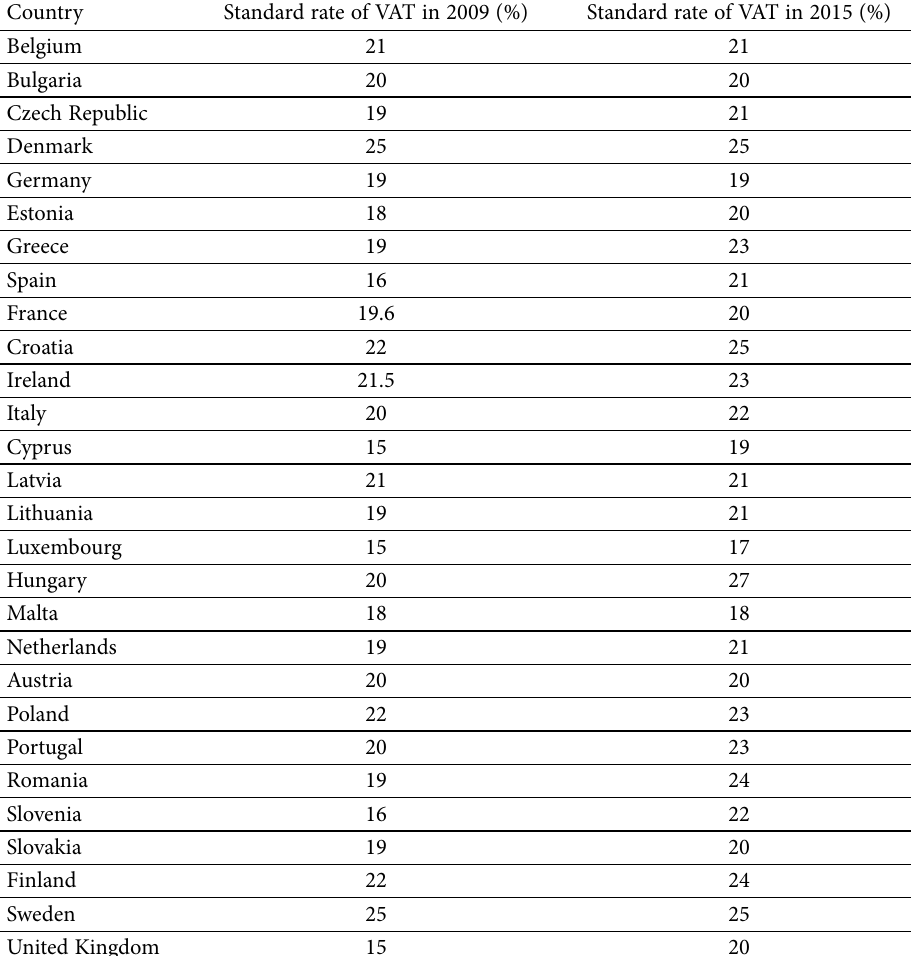
Table 1. The standard rate of VAT in EU countries Country Standard rate of VAT in 2009 (%) Standard rate of VAT in 2015